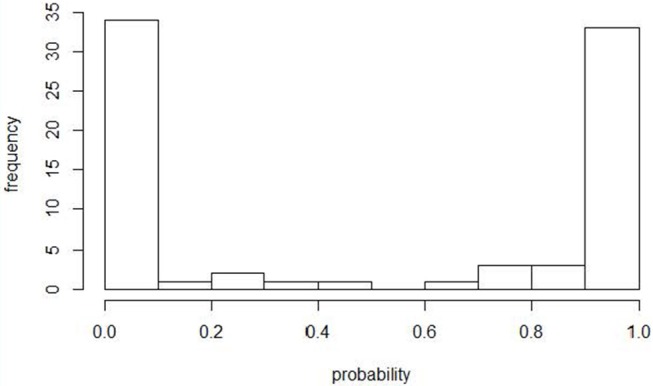
Histogram showing the estimated probabilities for being infected by neighboring farms after a rerun of the model defining primary outbreaks (12). The figure includes 80 fish groups with confirmed ISA during the study period 2004–June 2017. Fish groups with an estimated probability <10% were defined as primary ISA outbreaks.